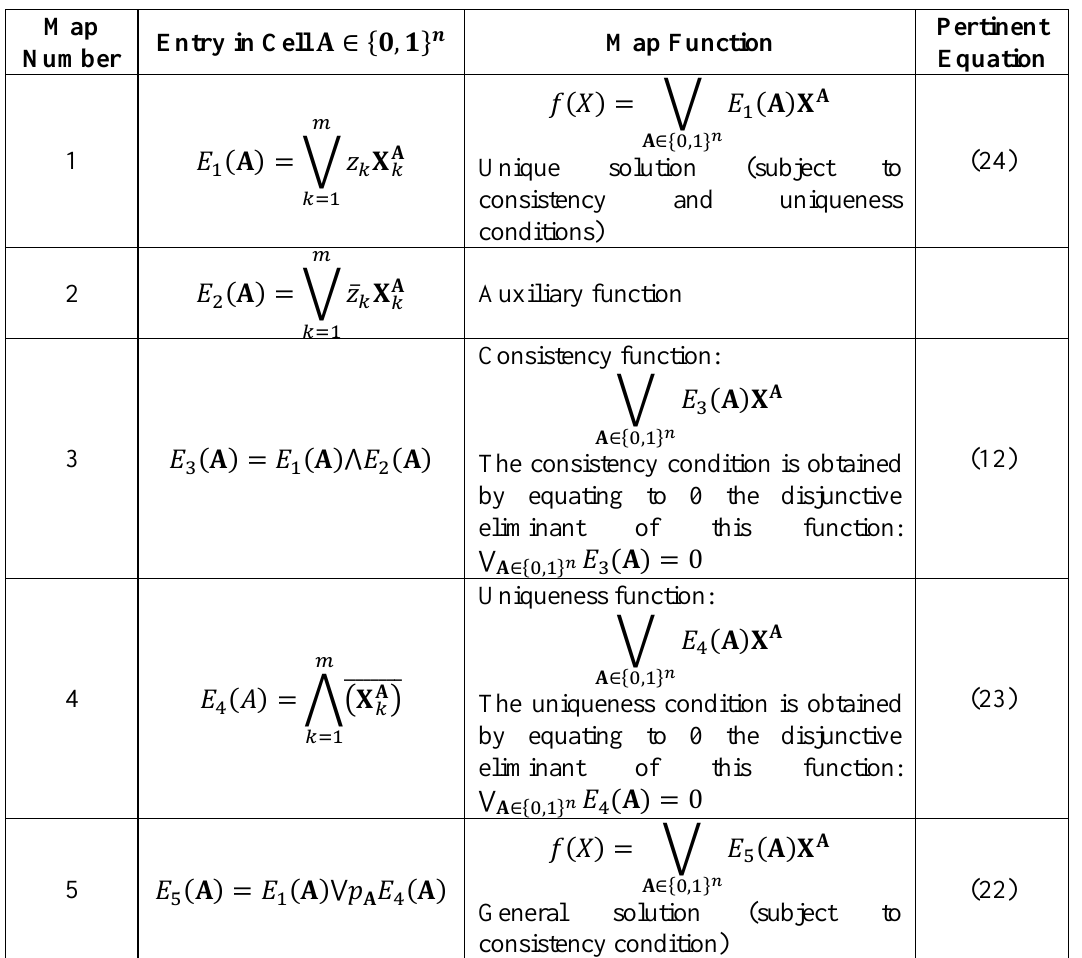
Table 1. Five VEKMs of map variables 𝐗 for achieving a (unique) consistent solution of the problem of